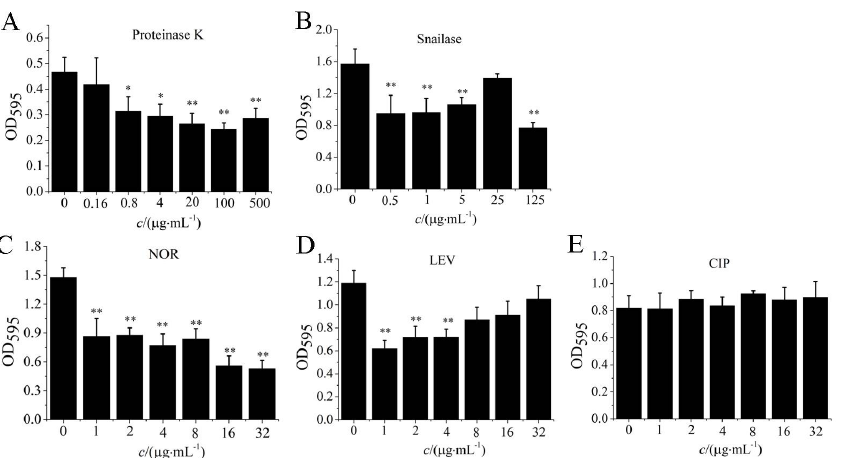
Figure 7. Effect of antibiotics and enzymes on S. aureus biofilm. Note. OD 595 values of crystal violet retention were measured to determine biofilm formation. After treating with proteinase K ( A ), snailase ( B ), norfloxacin ( C ), levofloxacin ( D ) and ciprofloxacin ( E ), the biofilm biomass of S. aureus W3 was represented by the OD value at 595 nm. NOR: norfloxacin, LEV: levofloxacin, CIP: ciprofloxacin. The biofilm of S. aureus W3 treated with antibiotics or enzymes at a concentration of 0 was used as the control group. “*” means p < 0.05, “**” means p < 0.01, compared to control. The values were means ± standard deviations ( n =